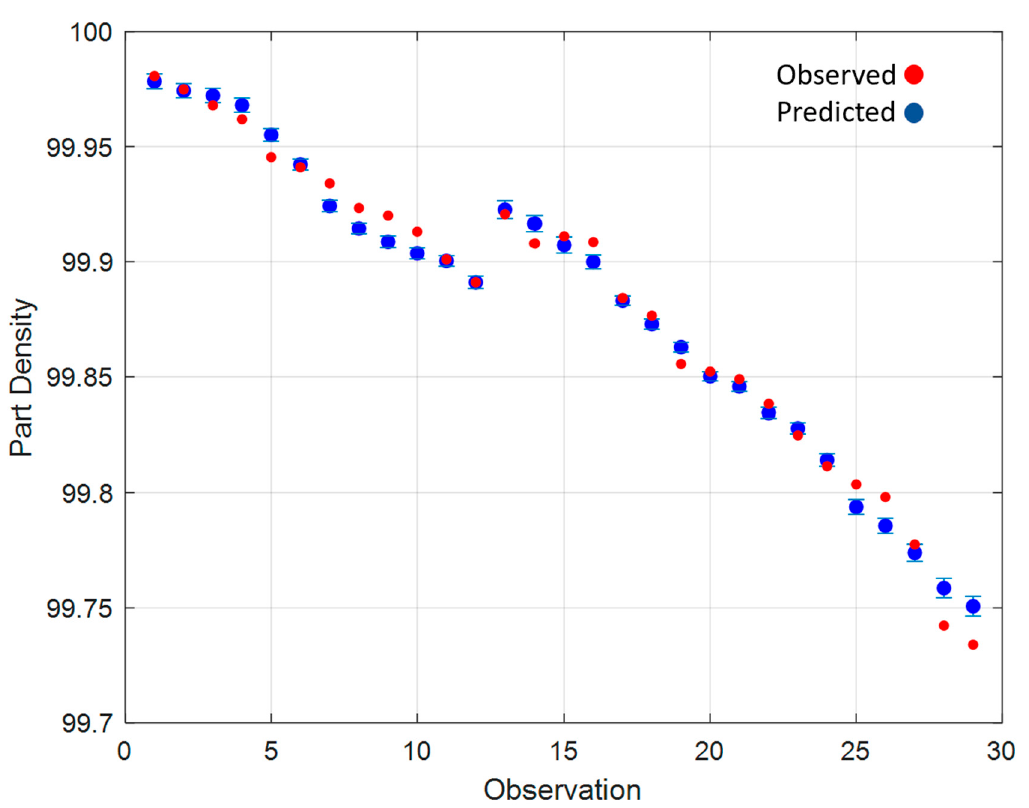
Figure 8. Part density model fitted values and observed part density values.